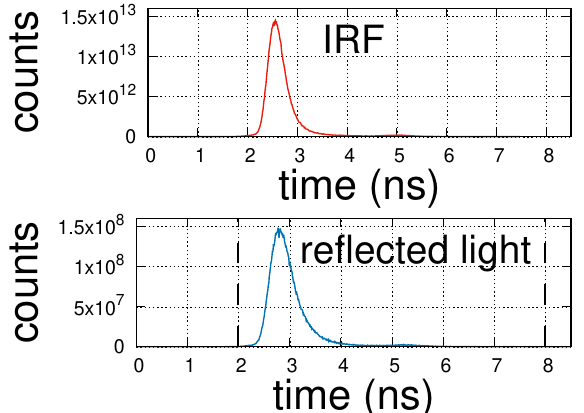
Figure 1. Measured data from TRS-80. The instrument response function and measured reflected light are shown in the upper and lower panels, respectively. In the lower panel, the dashed lines show = 8.00ns ( M t = t 1 = 2.00ns and t M t